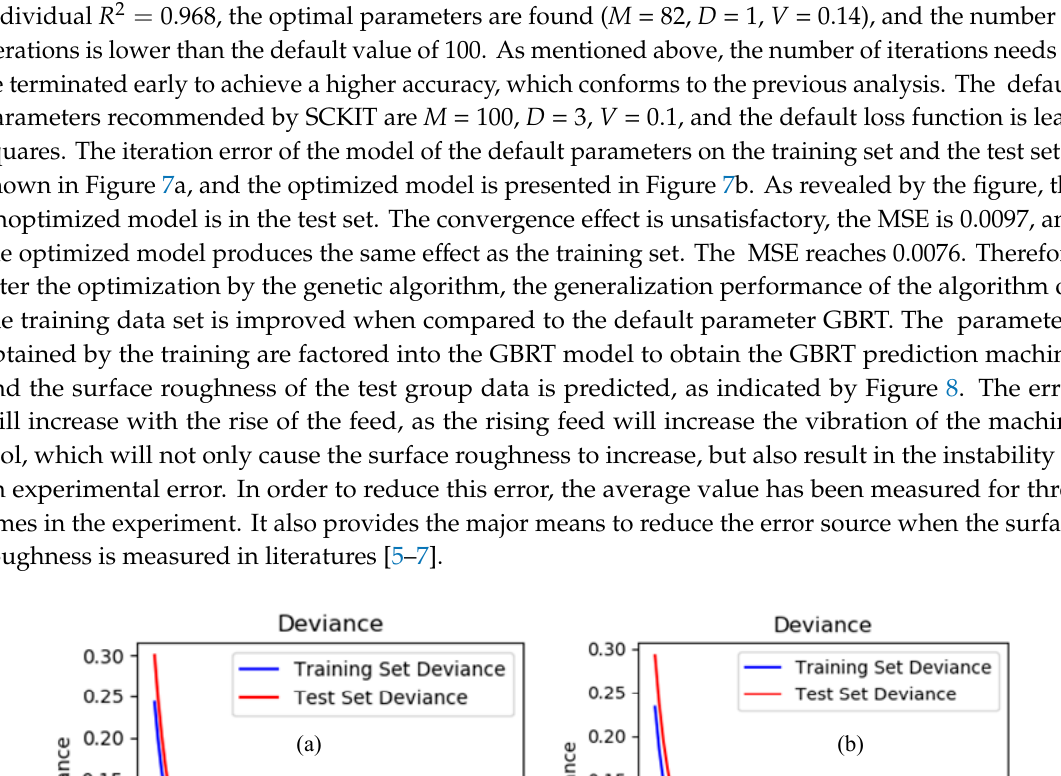
Figure 6. K-fold cross-verification flow chart.